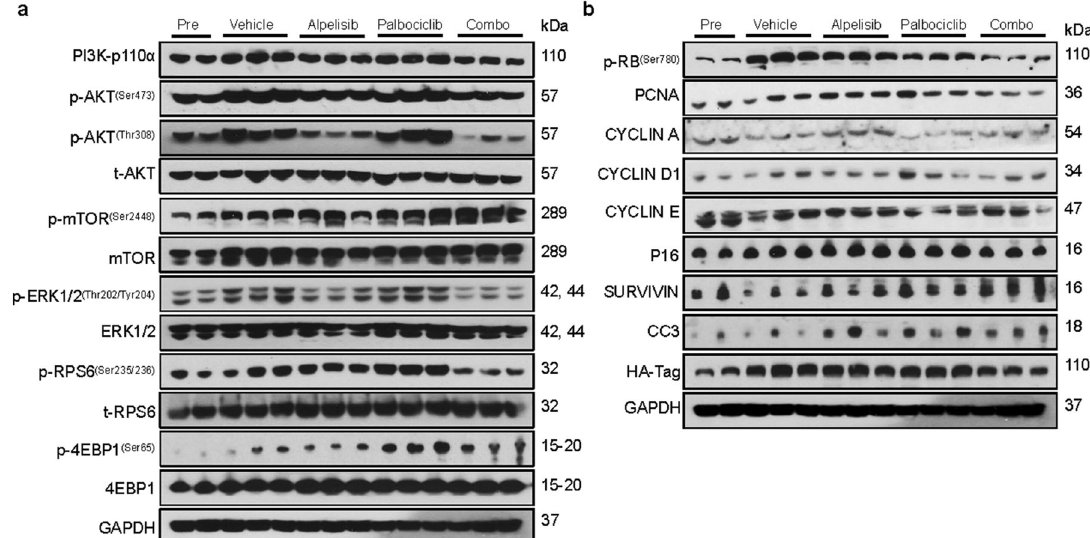
Fig. 8 Effects of alpelisib/palbociclib treatment on the levels of putative target proteins in livers from c-Met/H1047R mice. a Western blot an a lysis of AKT/mTOR and Ras/MAPK pathways in pretreated, treated with vehicle, alpelisib, palbociclib, and alpelisib/palbociclib c-Met/ H1047R mice. b Western blot analysis of proliferation signaling pathways in pretreated, treated with vehicle, alpelisib, palbociclib, and alpelisib/palbociclib c-Met/H1047R mice. Pre Pretreatment, Combo combined alpelisib/palbociclib treatment, CC3 CLEAVED